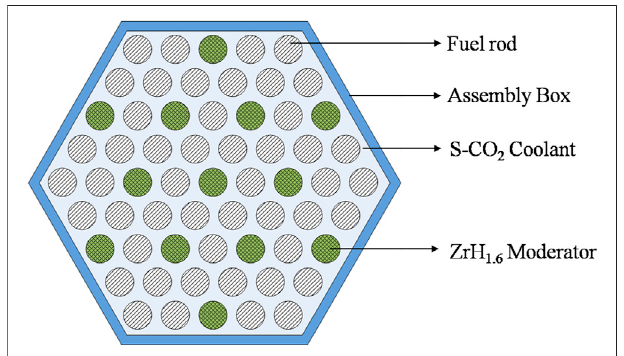
FIGURE 4 | S-CO 2 fuel assembly with ZrH 1.6